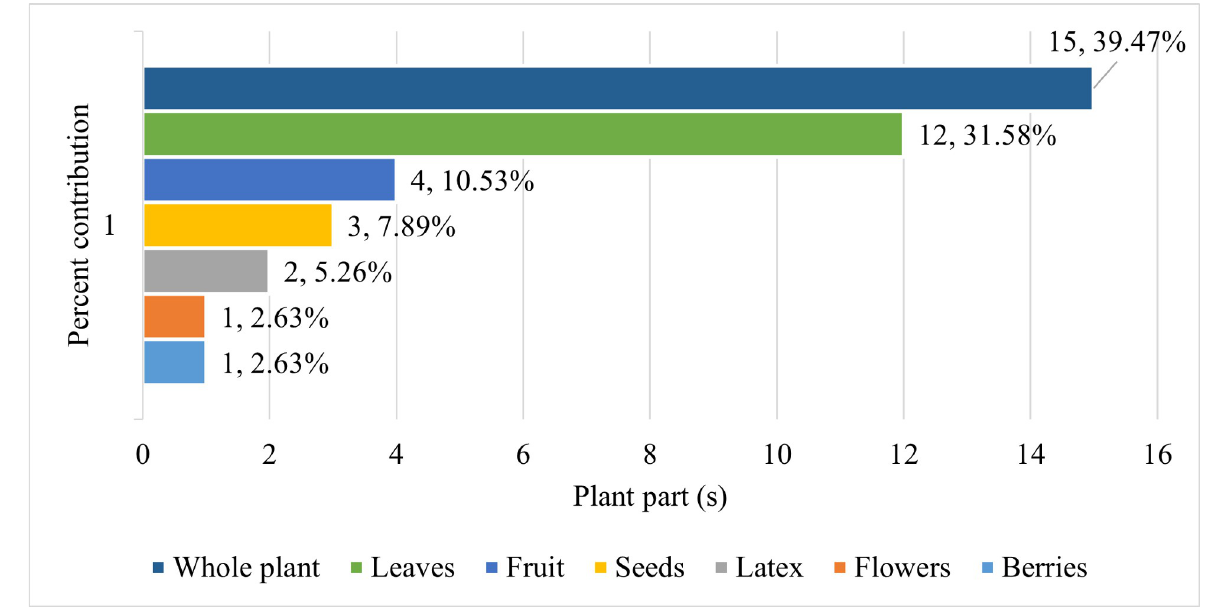
Fig 5. Percentage of contribution of different plant parts in livestock poisoning.